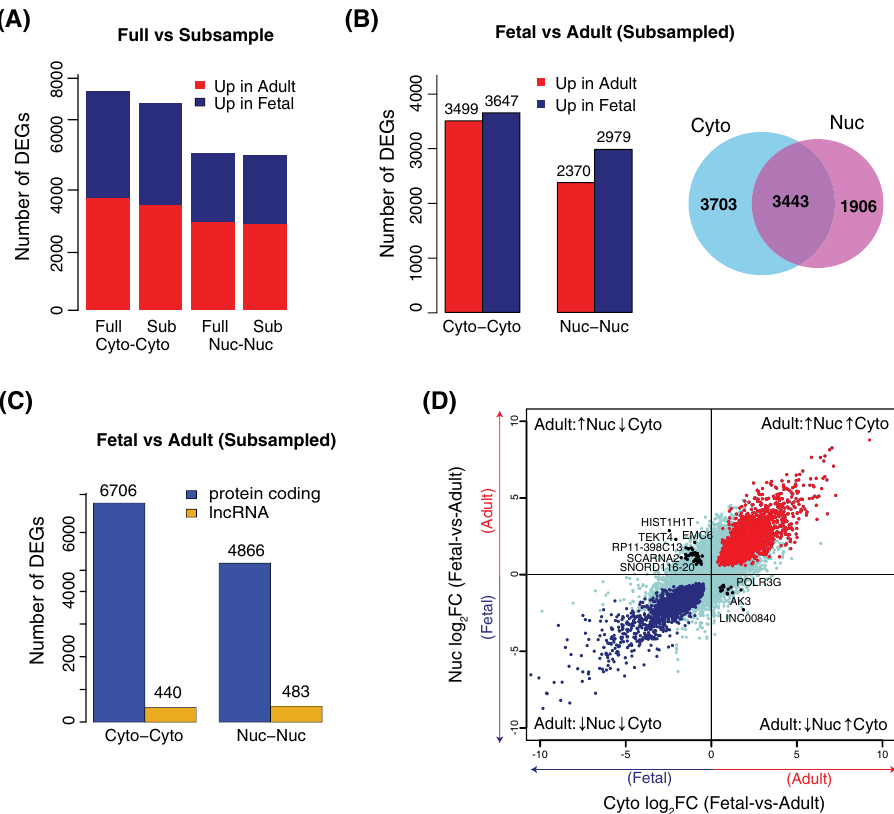
Figure 4. Cytosol and nucleus as a proxy for gene expression analysis. (A) Comparison of differential expression analysis between full and subsampled data. DEGs in Fetal-cyto vs. Adult-cyto and Fetal-nuc vs. Adult-nuc from the two datasets are shown. (B) Barplot showing DEGs in fetal and adult (cyto–cyto) and DEGs in fetal and adult (nuc–nuc). Overlap of total cytosolic and total nuclear DEGs is shown in the Venn diagram. (C) Barplot showing the distribution of differentially expressed protein-coding and lncRNA genes in cyto–cyto and nuc–nuc analysis. (D) Expression fold changes for transcripts in fetal and adult cortex cyto– cyto against nuc–nuc after subsampling. DEGs (red) overlap between cytosolic and nuclear fractions in adult, cytosolic and nuclear in fetal (blue). Genes significantly abundant in the fetal cortex using cytosolic samples but abundant in the adult cortex with nuclear samples, and those abundant in adult (cytosol) but not fetal (nuclear) are highlighted in black. Genes not reaching significance in either of the groups are shown in light